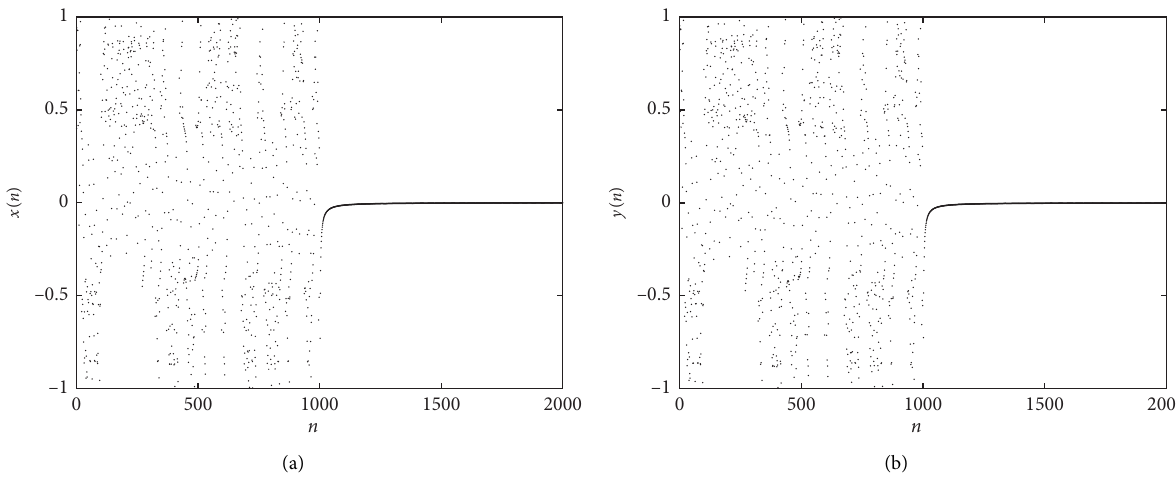
Figure 13: The results of the stabilization of system (10): (a) the variation of x ( n ) with n and (b) the variation of y ( n ) with n